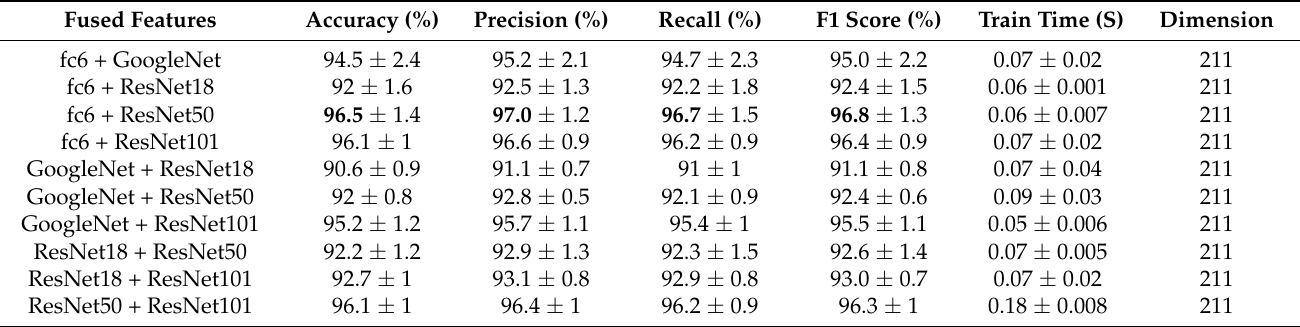
Table 3. Performance metrics and training time of SVM classifier with fused deep features (bold font shows the best performance).